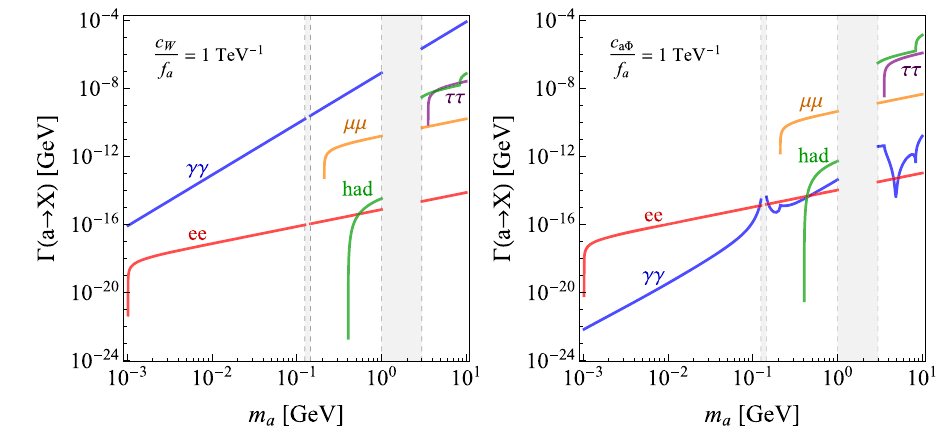
Fig. 4 ALP partial decay widths to various two-particle channels as a function of m a , in presence of either c W (left panel) or c a (cid:7) (right panel), for c W / f a = 1 TeV − 1 and c a (cid:7) / f a = 1 TeV − 1 , respectively. The grey shaded areas correspond: (i) to the pion mass region, which is